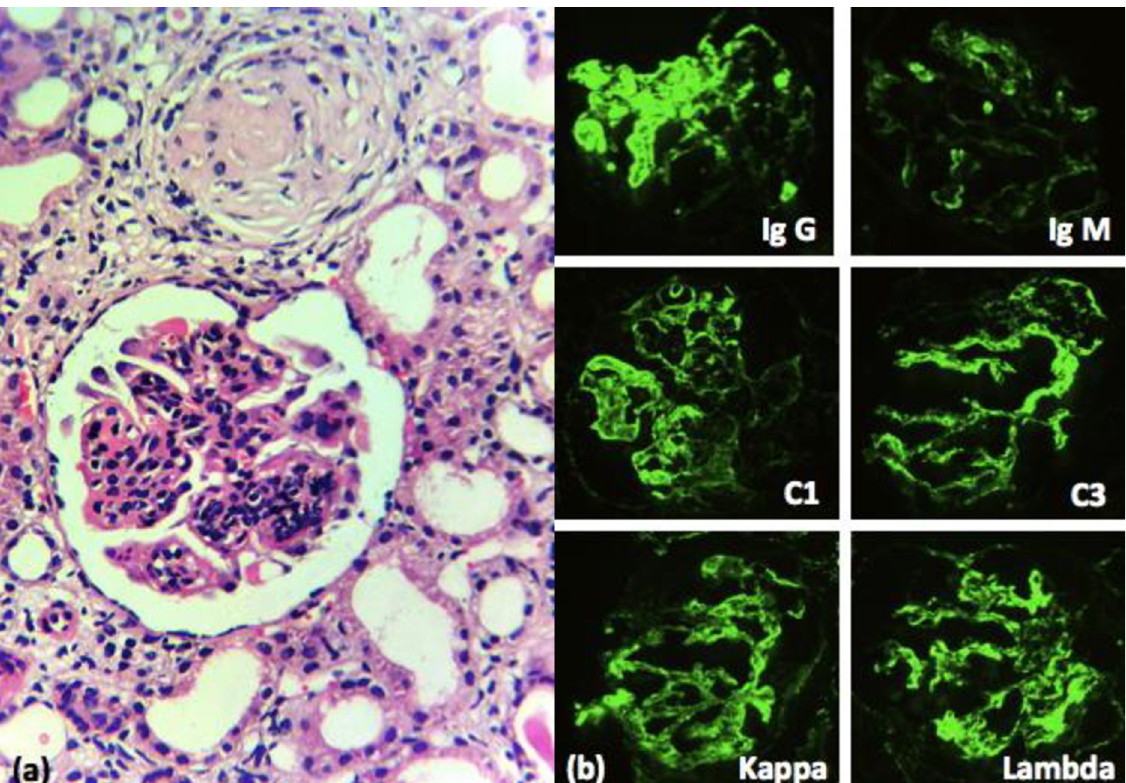
Fig 8. a Lupus nephritis Class IV with mesangial and endocapillary proliferation (H&E stain x400). b. DIF shows full house positivity.